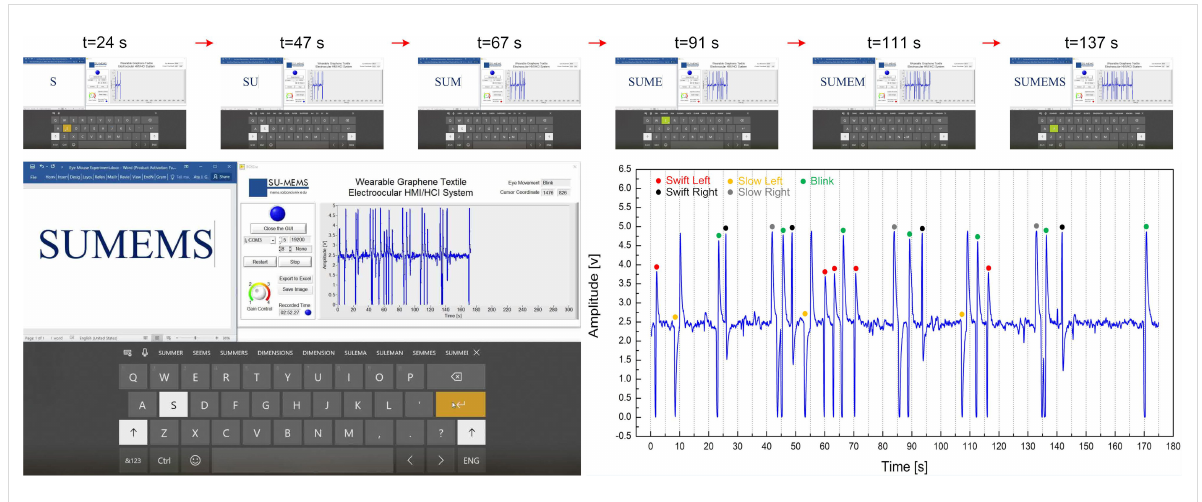
Figure 3: The first testing scenario shows the plot of induced EOG signals with inserted interpretations for each eye movement, which are used to mimic the movements of a mouse cursor to write “SUMEMS” (Sabanci University MEMS Group).